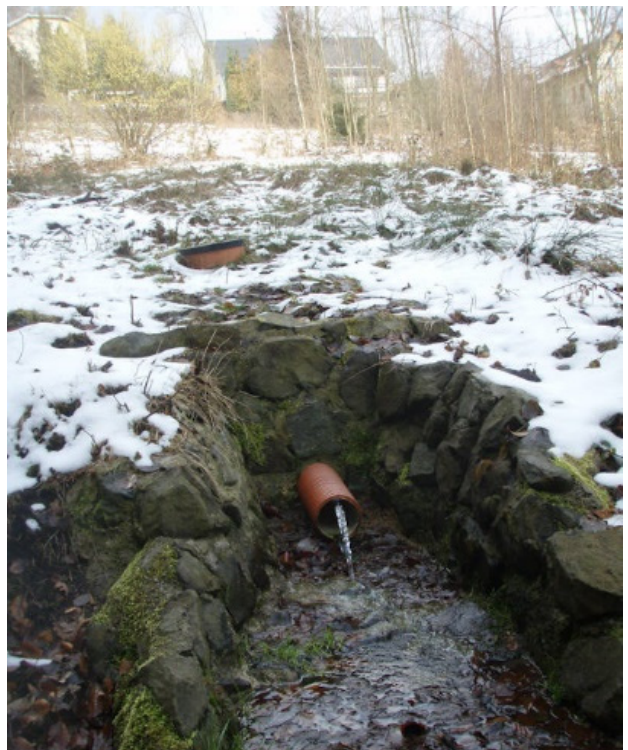
Figure 16. The Schindler spring in Kokonín park, March 2016. The original waterworks building was demolished, and the water was drained in 2013. Photo by Viktor Goliáš.